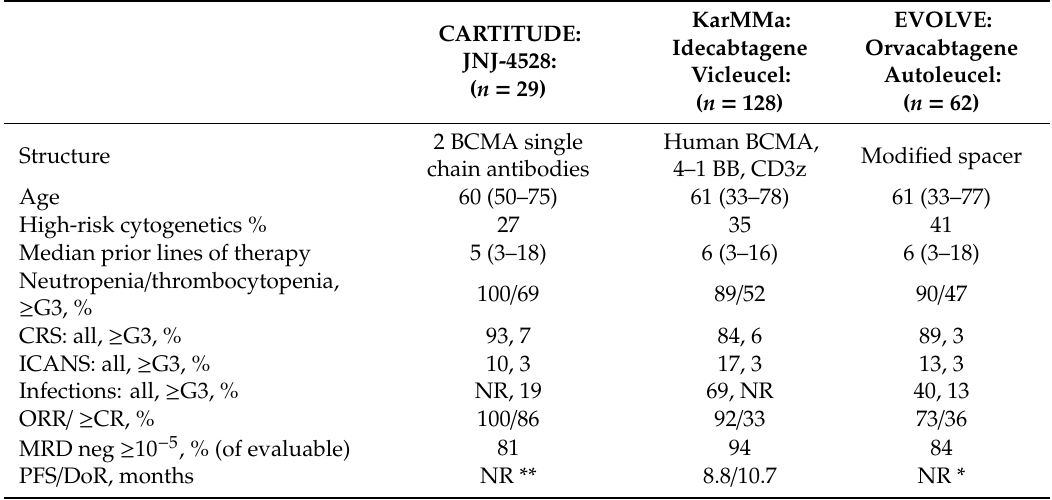
Table 5. Comparison of the three chimeric antigen receptor (CAR-) T cell